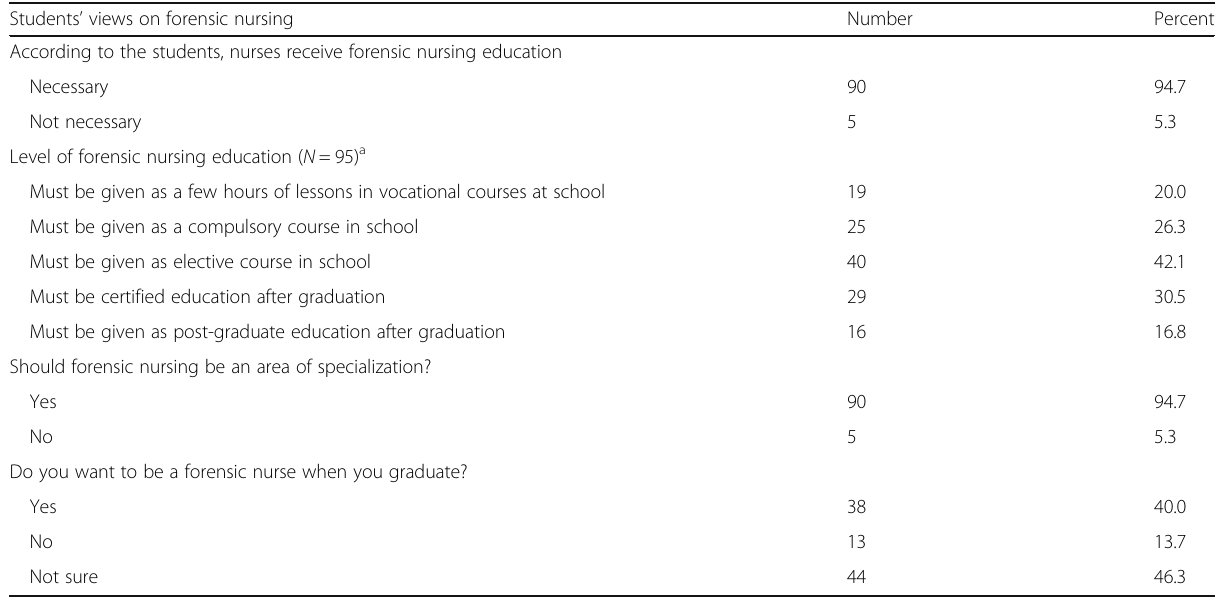
Table 2 Students ’ views on forensic nursing ( N =